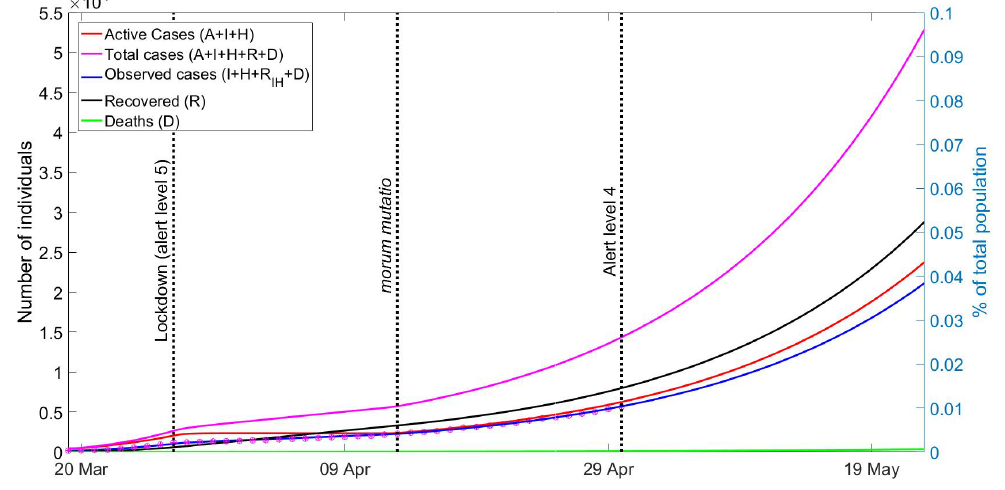
Fig. 5. COVID in South Africa: Alert Level